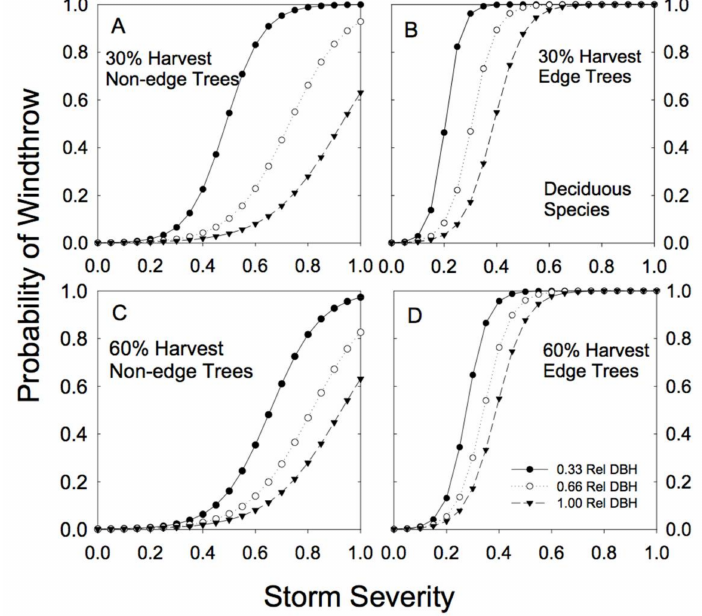
Figure 7. Predicted susceptibility to windthrow as a function of relative tree size and proximity to a forest edge for the group of deciduous species. The predictions were generated from Model 4a, using the parameters reported in Table 2, for two different levels of prior harvest (30% and 60% basal area removal) and for 3 different relative tree sizes (0.33, 0.66, and 1.00 relative DBH). ( A ) For non-edge trees in a plot with a 30% harvest; ( B ) edge trees in a plot with a 30% harvest; ( C ) non-edge trees in a plot with a 60% harvest; ( D ) edge trees in a plot with a 60%